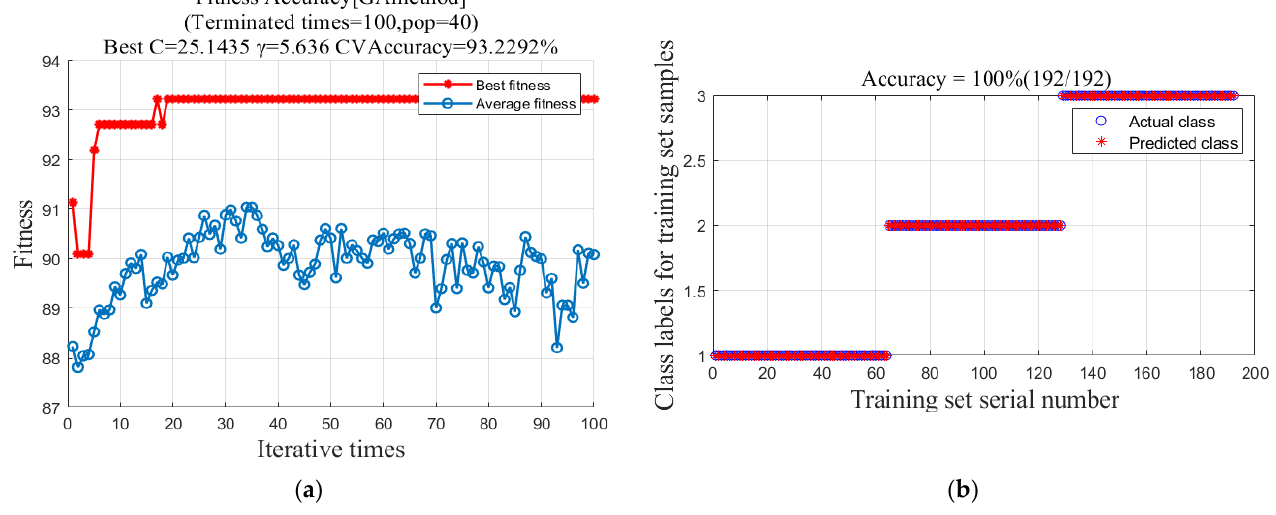
Figure 10. Optimizing the training process of C and γ by GA; ( a ) iterative process; ( b ) training set classification results.